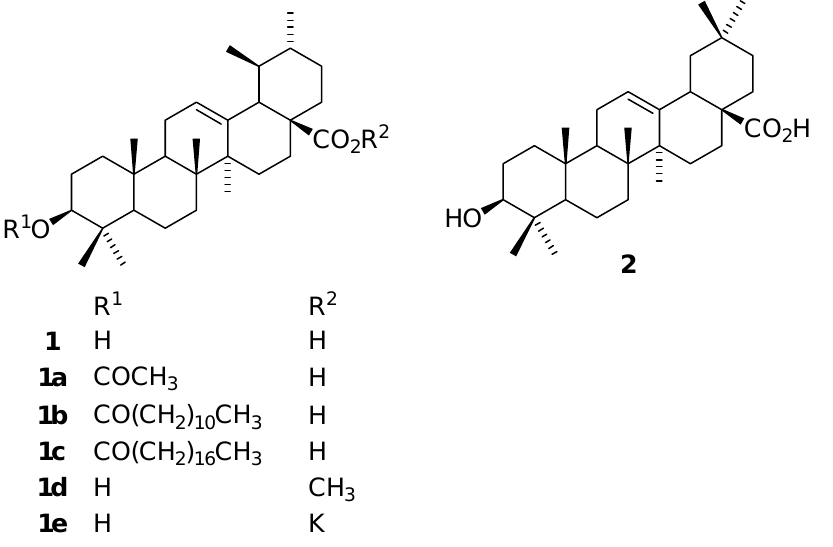
Figure 1. Chemical structures of ursolic acid ( 1 ), oleanolic acid ( 2 ), and the semi-synthetic ursolic acid derivatives 1a , 1b , 1c , 1d and 1e